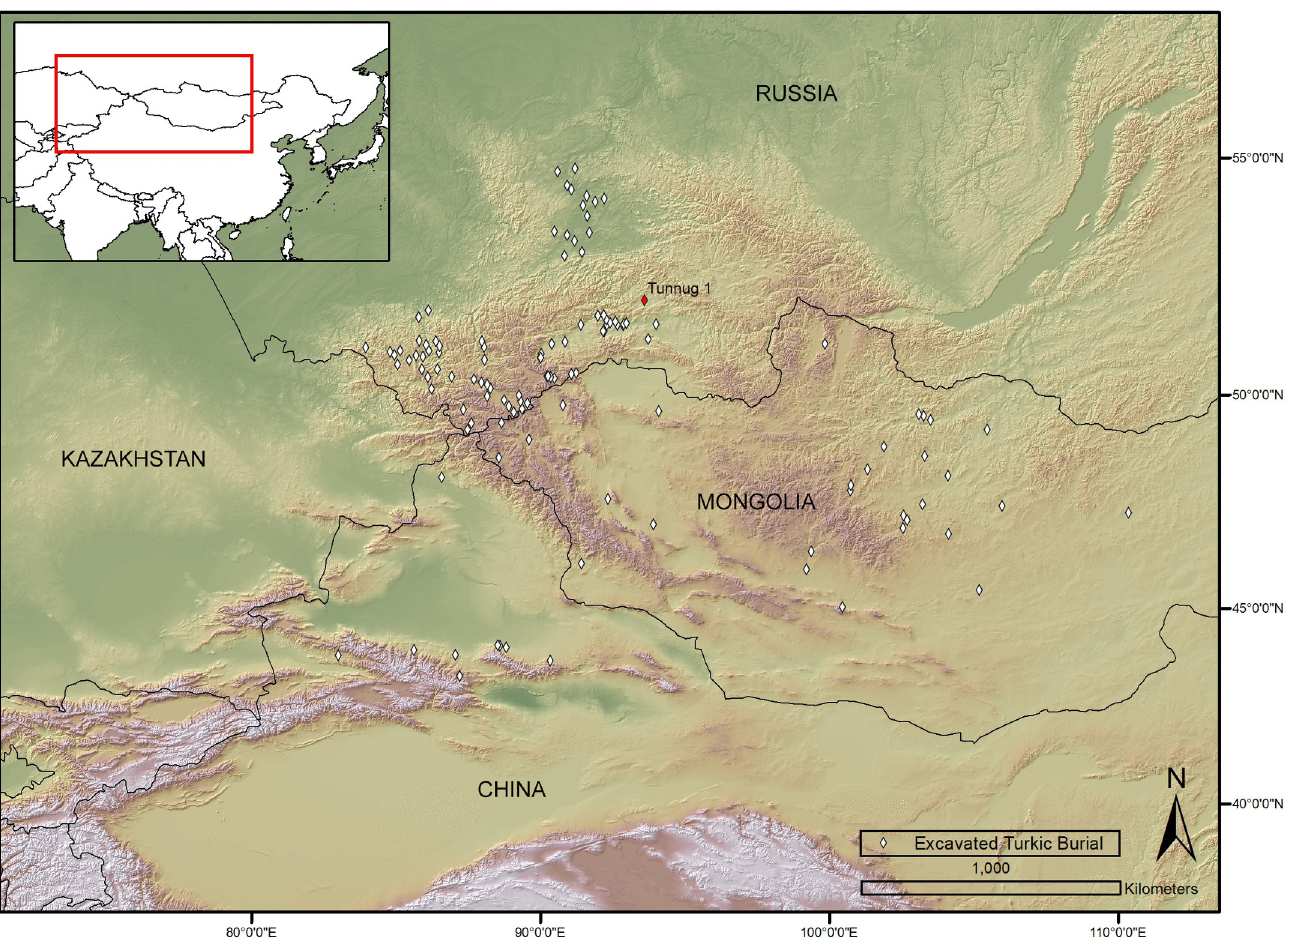
Fig 1. Distribution of Turkic burial structures in Inner Asia (adapted from [55] for sites in Altai-Sayan region and Mongolia. Map created by G. Caspari using ArcMap 10.4 by ESRI. We acknowledge the use of SRTM 1 Arc-Second Global Digital Elevation Model).